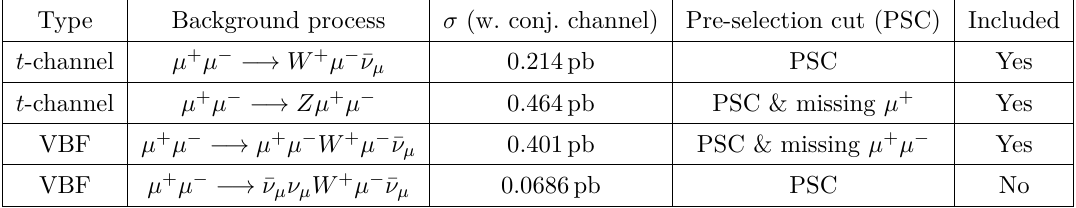
Table 4 . N µ background at 10 TeV. The cross section includes the charge conjugate process.